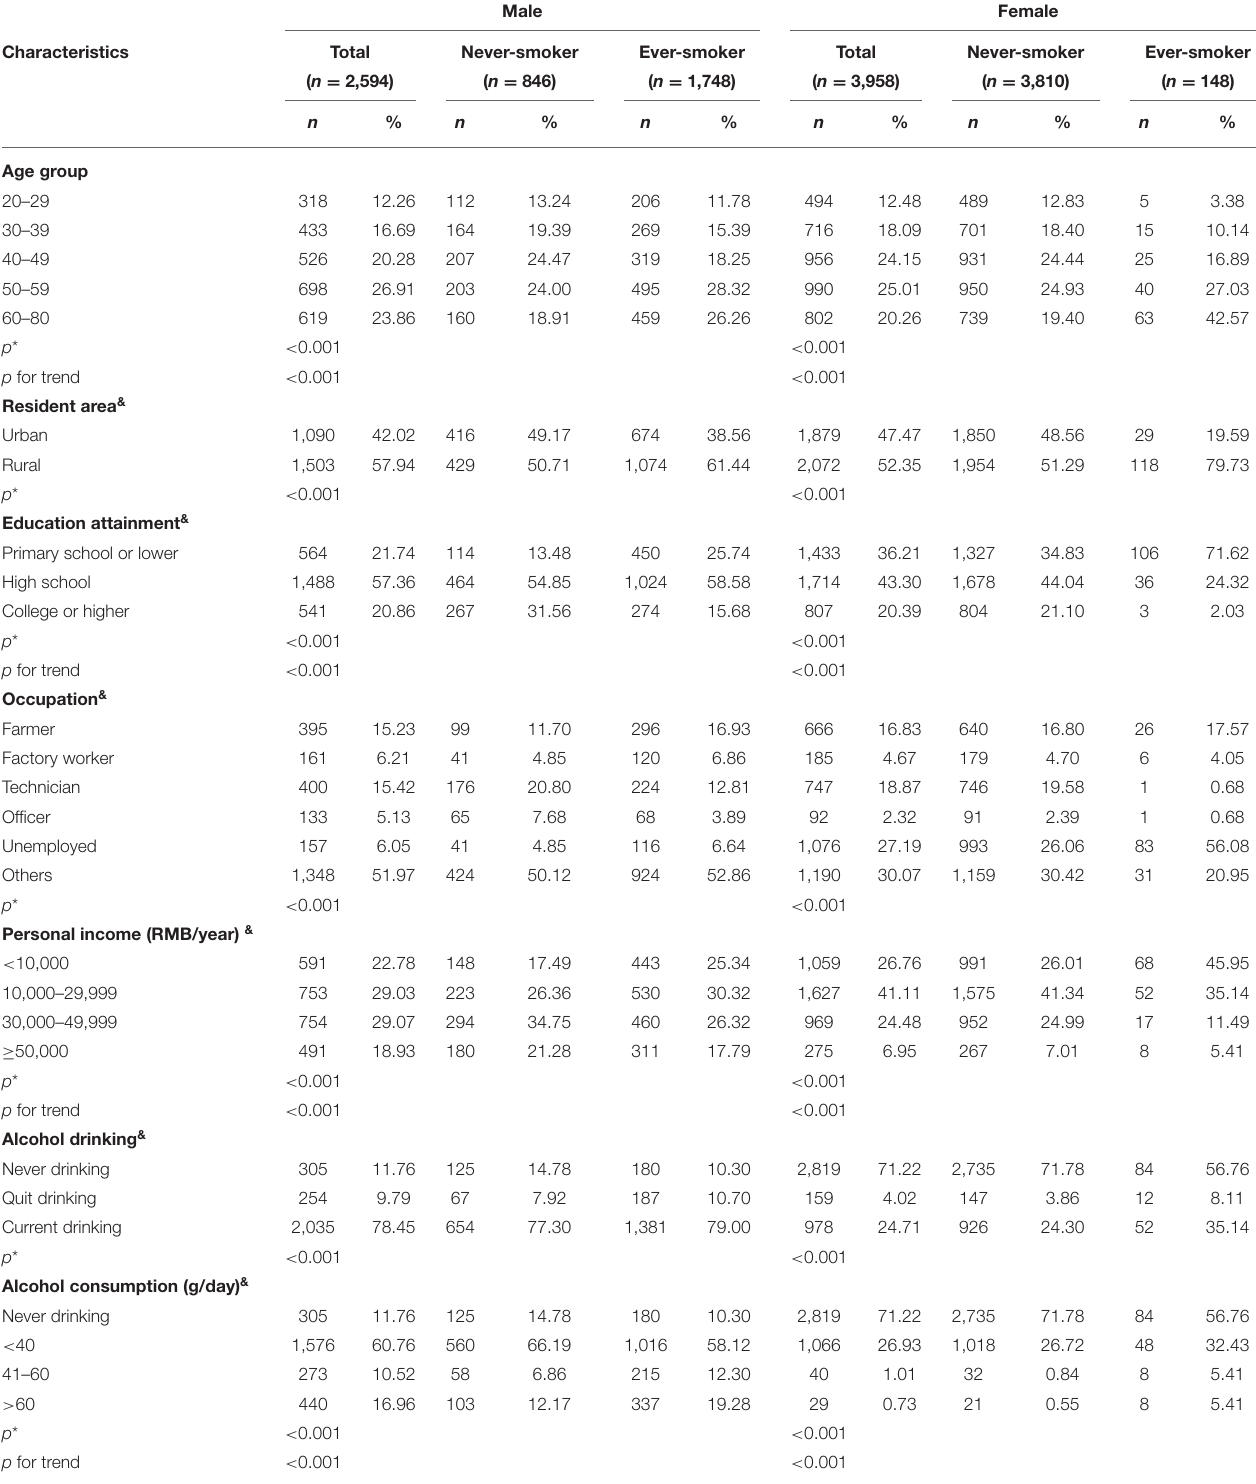
TABLE 1 | Characteristics of participants in Hebei Province of China, stratified by smoking status, 2017. Male